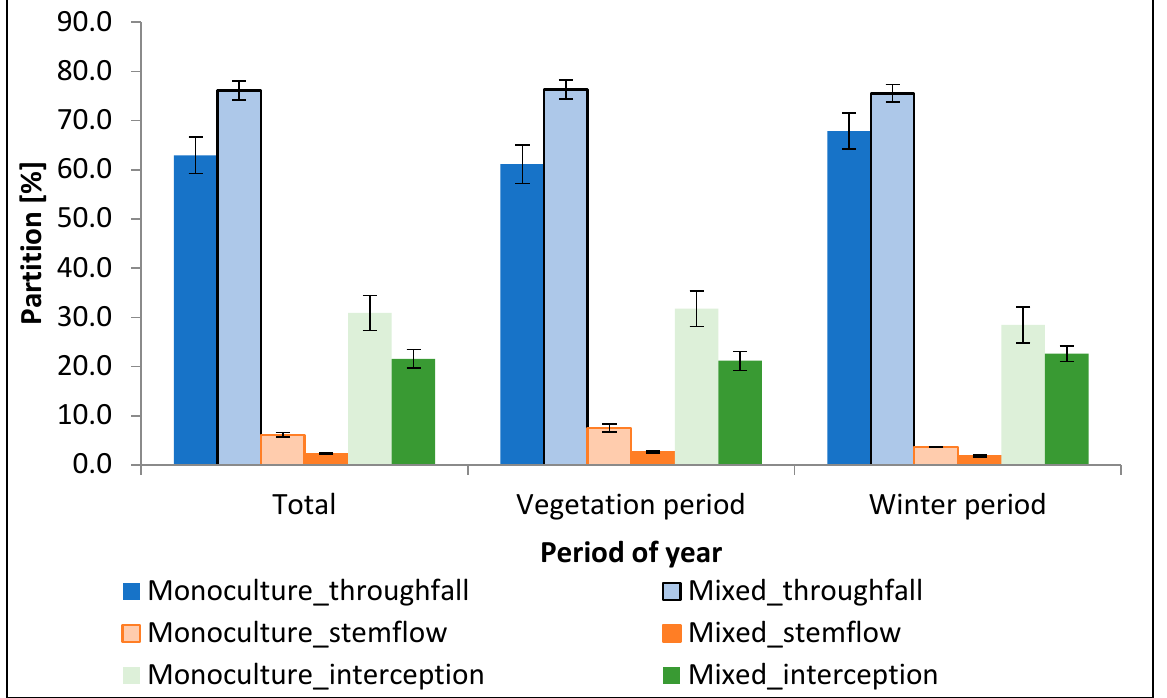
Figure 3. Mean values of the rainfall partitions within the monoculture and mixed forests during the year, vegetation period and winter period.